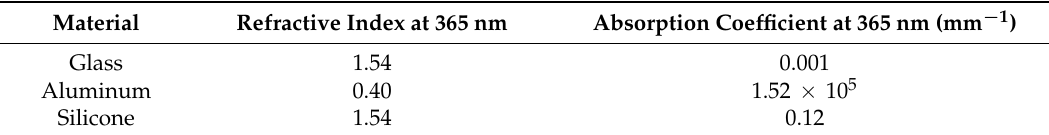
Table 2. Input parameters in Tracepro ray-tracing.